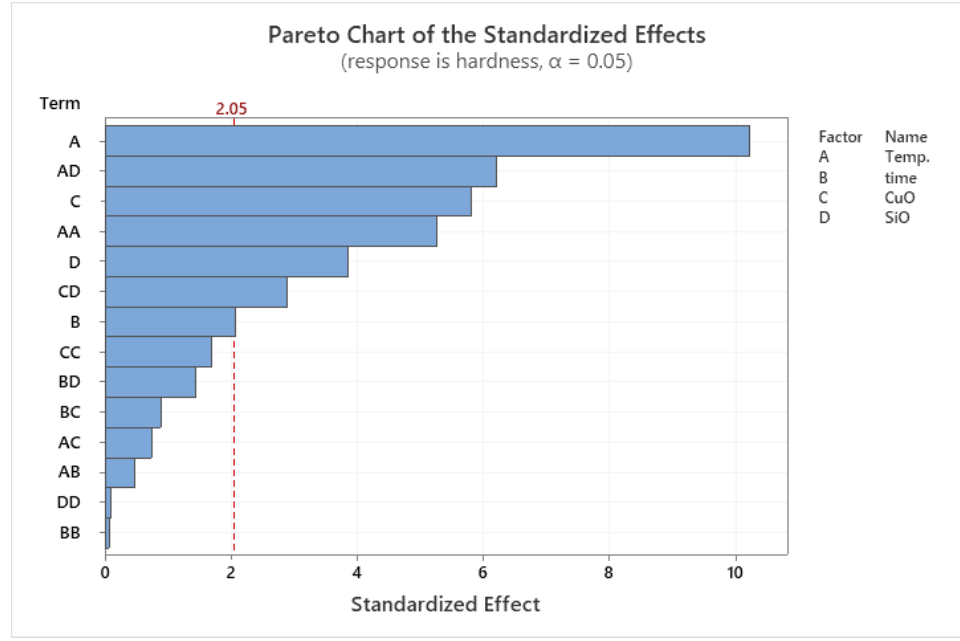
Table 8. R value for microhardness by RSM.